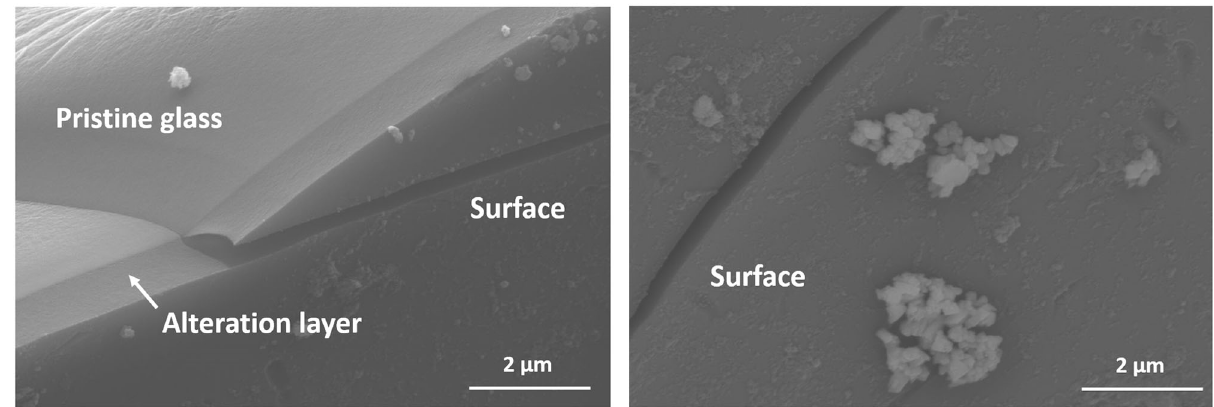
Fig. 6 SEM image of polished surface of day 126 monolith. Secondary phases, not observed for earlier samples, have now begun to form. Left image shows all three portions of the glass (pristine, alteration layer, and surface). The image on the right shows a close up of the secondary phases seen on the